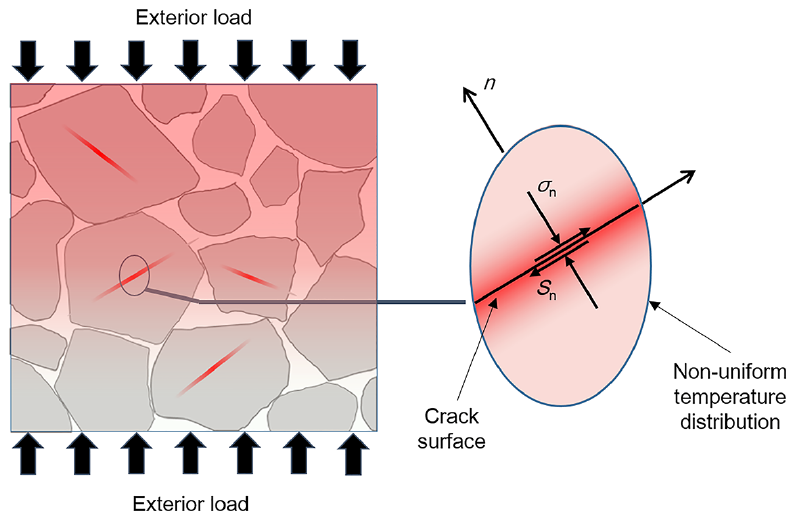
Figure 6. Heating process and non-uniform temperature distribution in PBX1314.